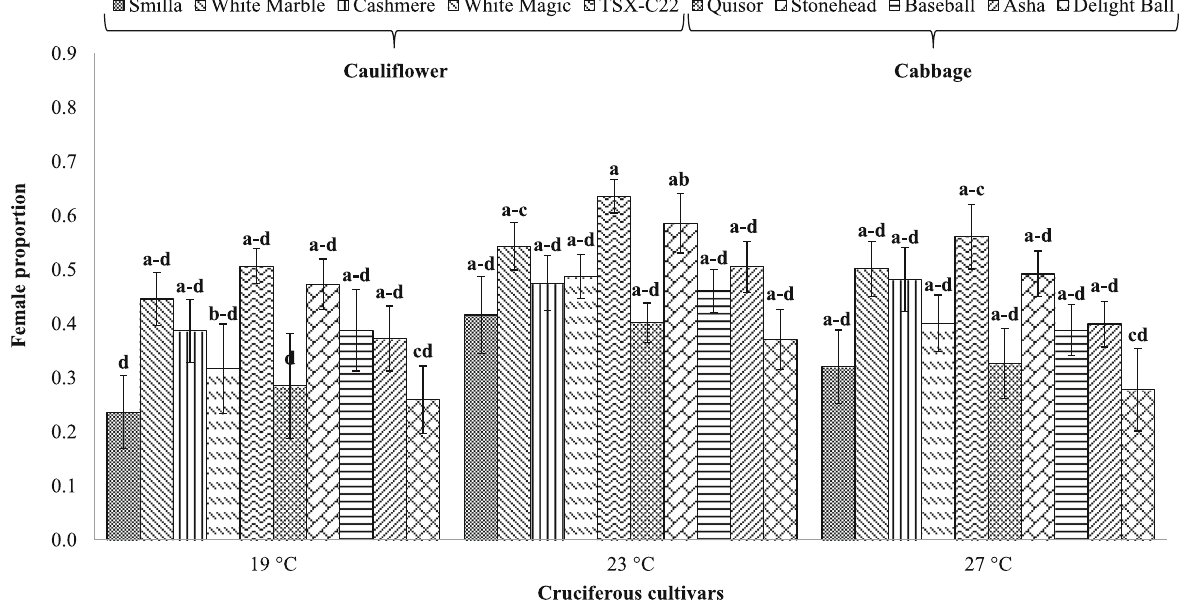
Fig. 2 Sex ratio in D. insulare ’ s progeny on cruciferous cultivars under different temperature